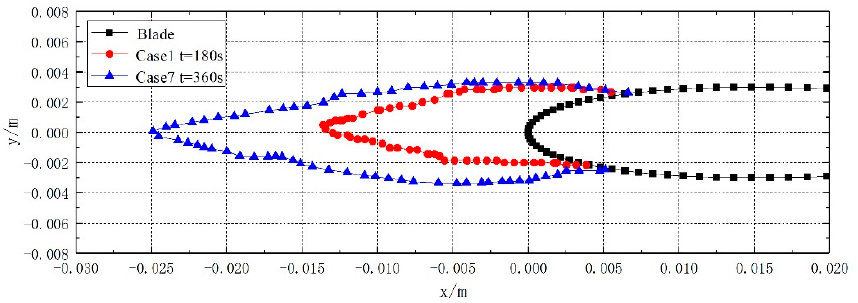
Figure 11. Comparison of ice shapes under different icing times.